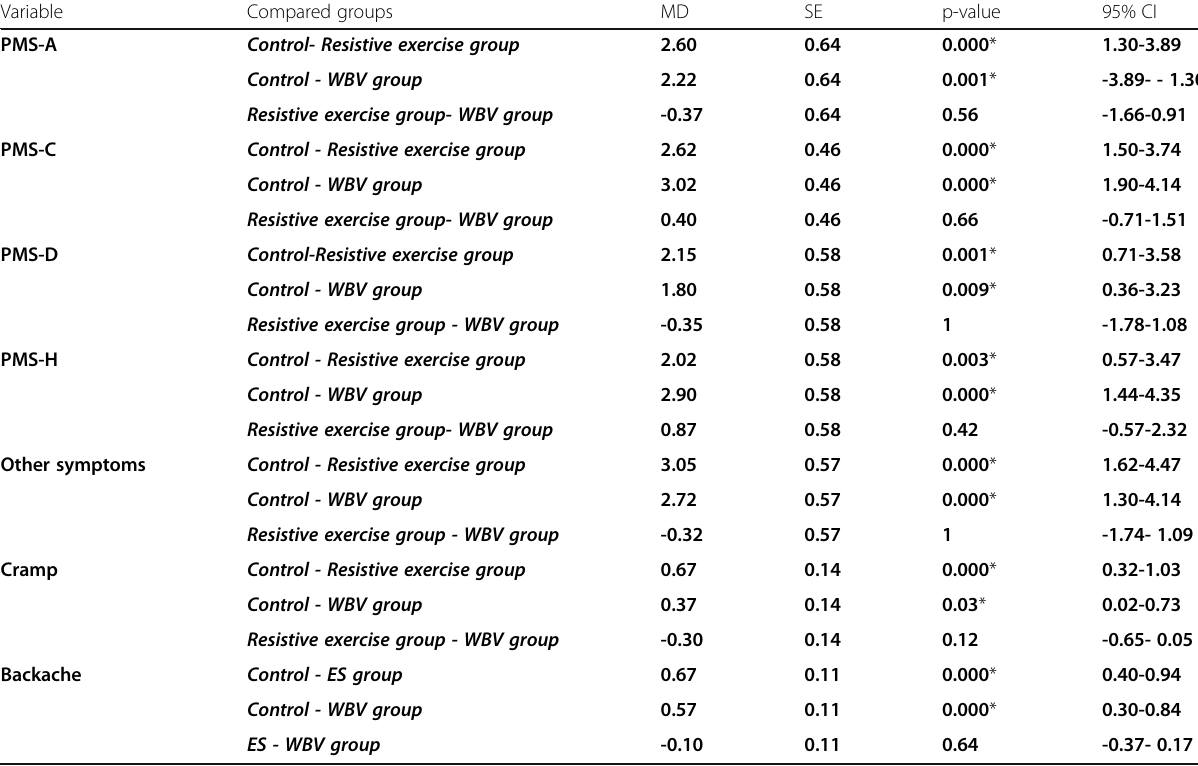
Table 3 The mean difference between groups for all PMS symptoms Variable